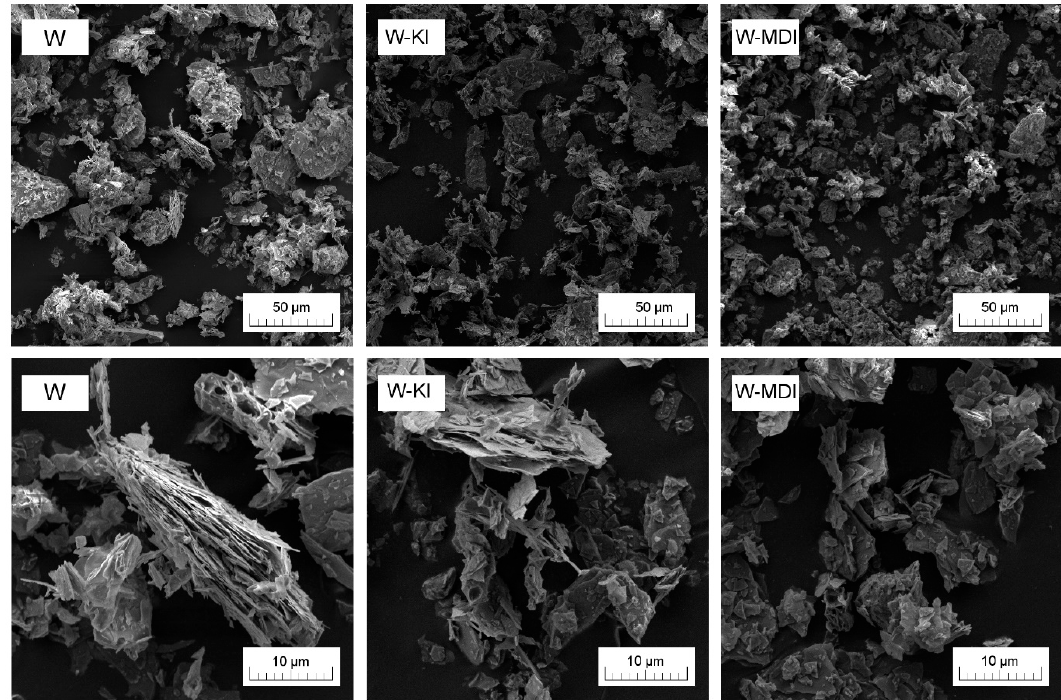
Figure 5. SEM images of the fillers taken with using magnification of 1000x and 5000x.